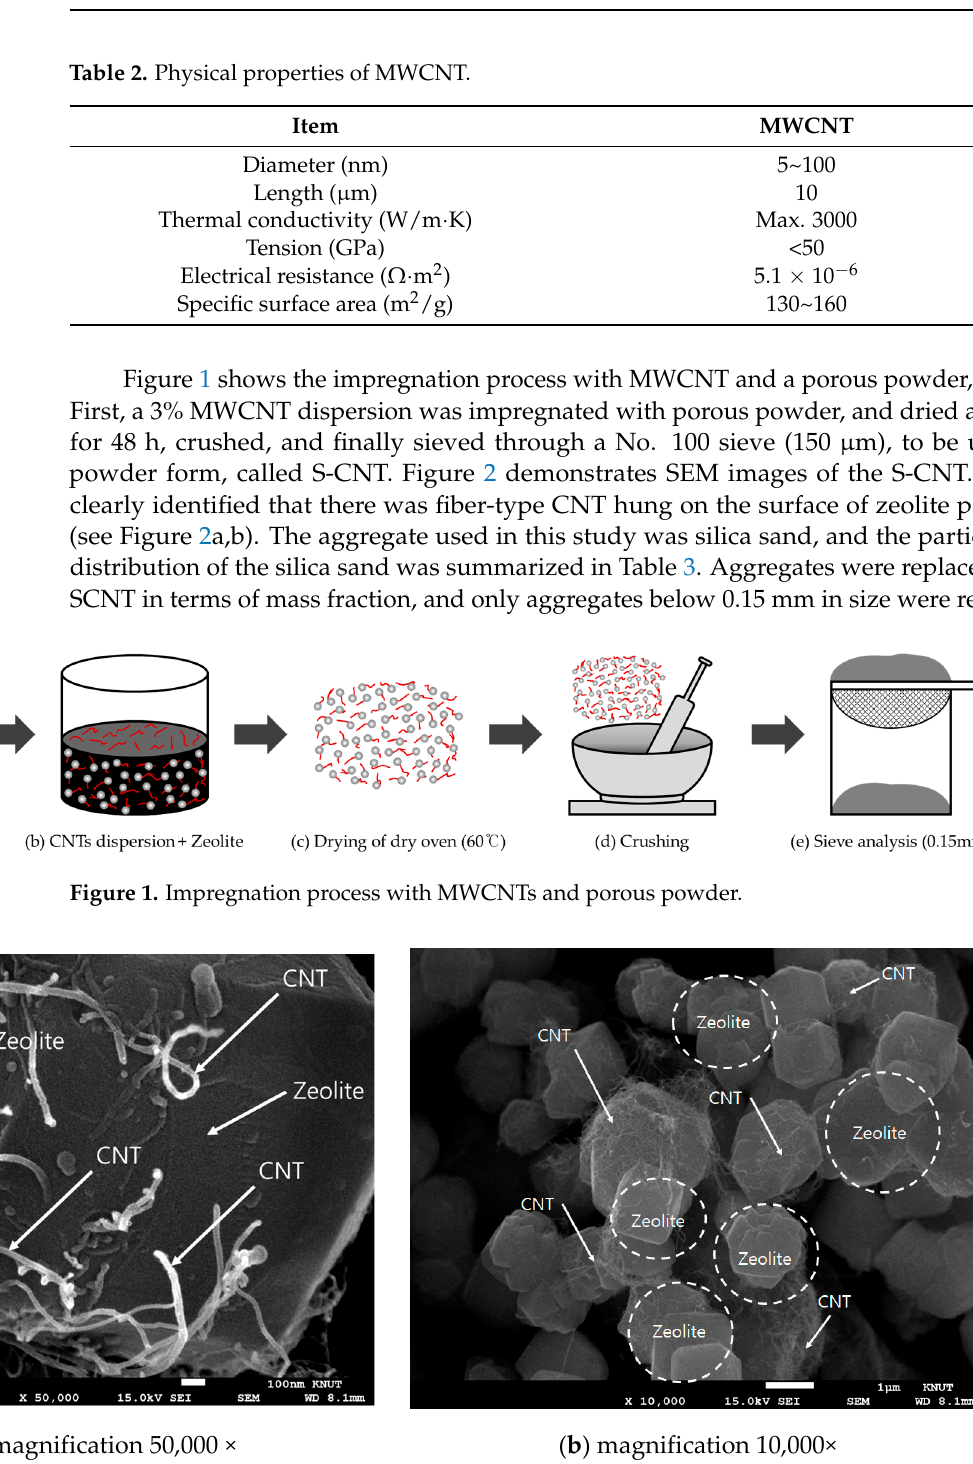
Figure 2. S-CNT SEM images: ( a ) magnification 50,000×; ( b ) magnification 10,000×.